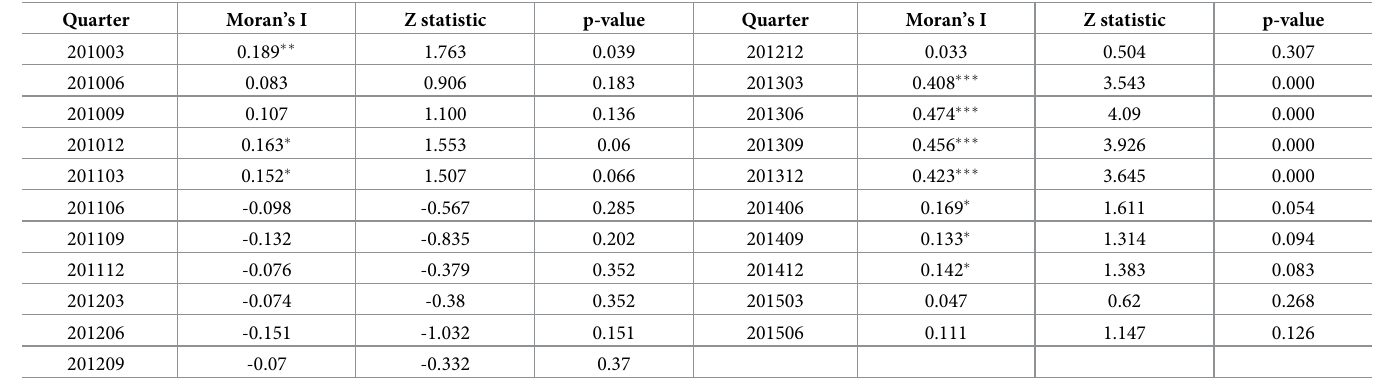
Table 4. Moran’s I of CPI from 2010 to 2015